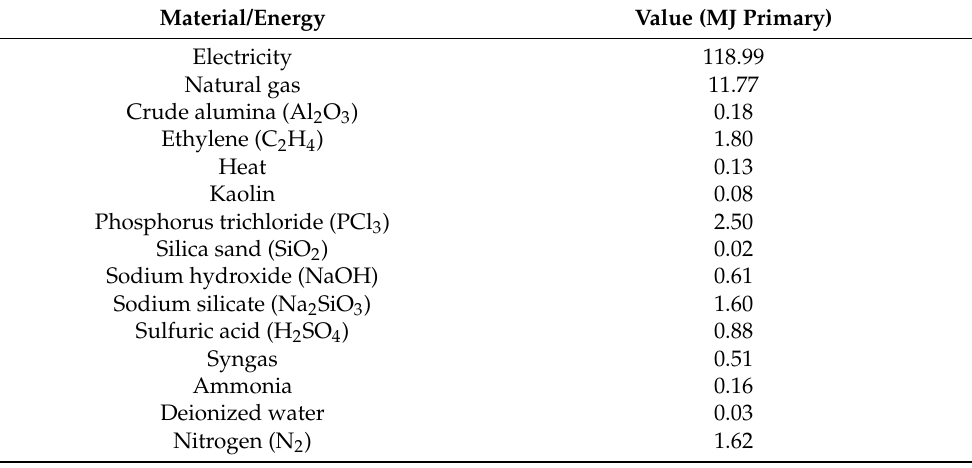
Table 6. NRE resulted from material and energy inputs in pyrolysis process included ZSM-5 catalyst. Material/Energy Value (MJ Primary) Electricity 118.99 Natural gas